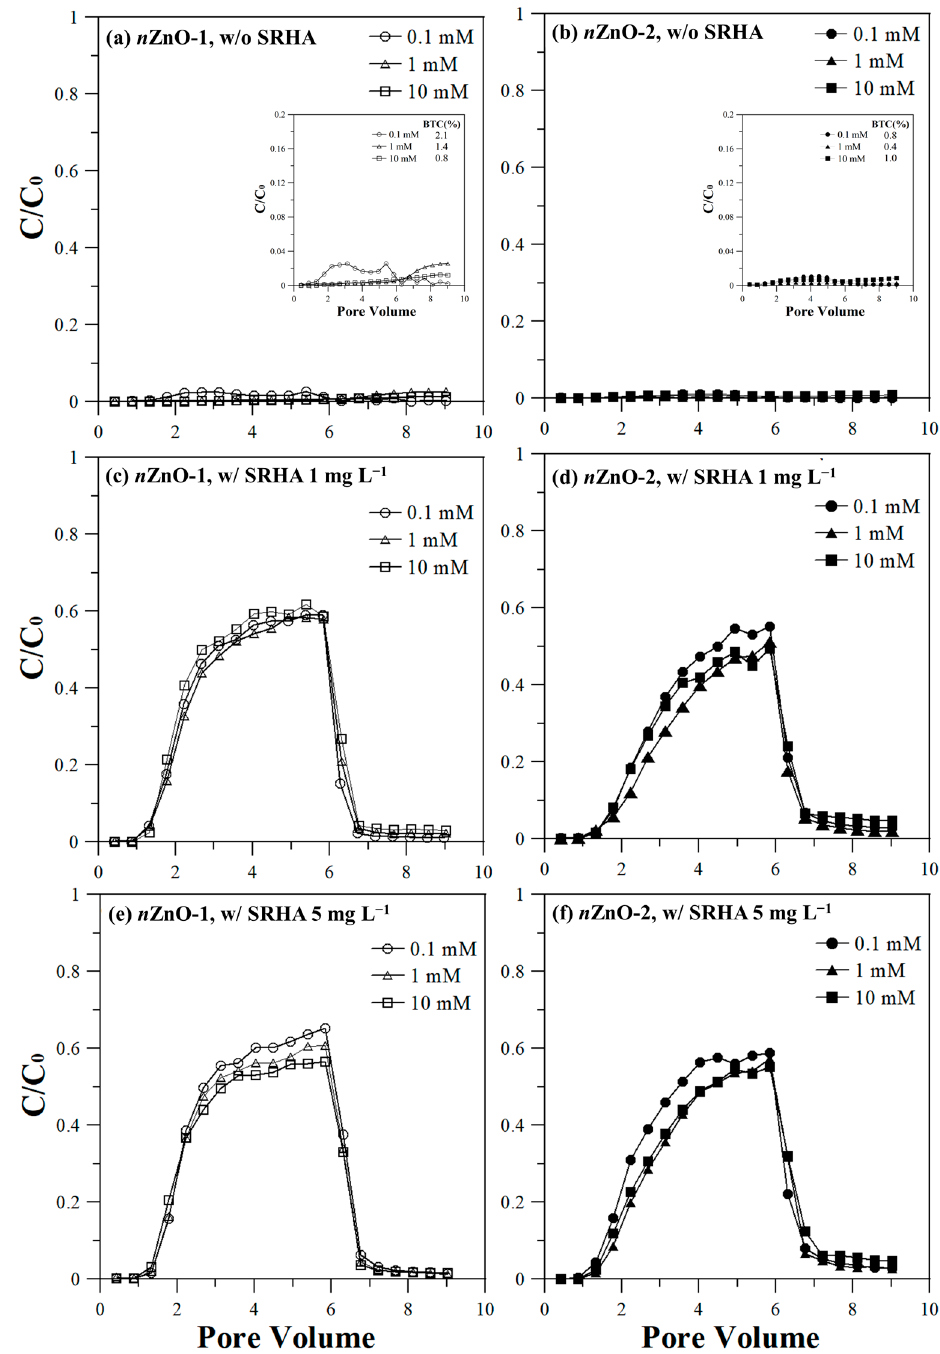
Figure 3. Breakthrough curves of n ZnO-1 (open symbol) and n ZnO-2 (solid symbol) in the absence ( a , b ) and presence ( c – f ) of suspended SRHA at difference ionic strengths in NaCl solution (0.1–10 mM). The inset of ( a , b ) is the enlarged image of the BTC profiles for clarity; note that the BTC percent is ≤ 2% for all cases, which is considered negligible. C/C 0 represents normalized concentration; here, C and C 0 represent the concentration of NPs passing through the column at certain pore volume and of injected NPs suspension, respectively. The pore volume is defined as t/VQ; here, t, V, and Q represent time, column void volume, and volumetric flow rate.